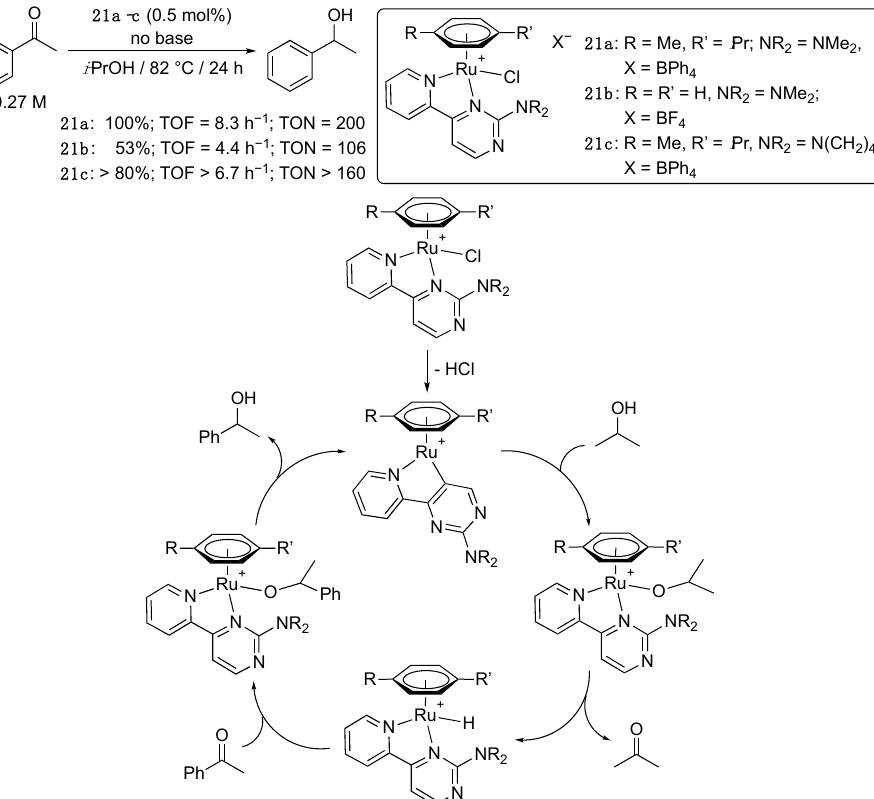
Scheme 10. Base-free TH of acetophenone triggered by roll-over cyclometalation of the 2-(2-dialkylaminopyrimidin-4-yl)pyridine ligand of complexes 21a – c and proposed mechanism. The most active 2-(pyrimidin-4-yl)pyridine complex 21a was shown to efficiently catalyze the base-free reduction of 11 aromatic and aliphatic ketones (0.27 M) in isopropanol at reflux with a catalyst loading of 0.5 mol.% (Scheme 11). With the exception of methyl β -naphtyl ketone, all substrates were converted with yields over 80% in 24 h [25].